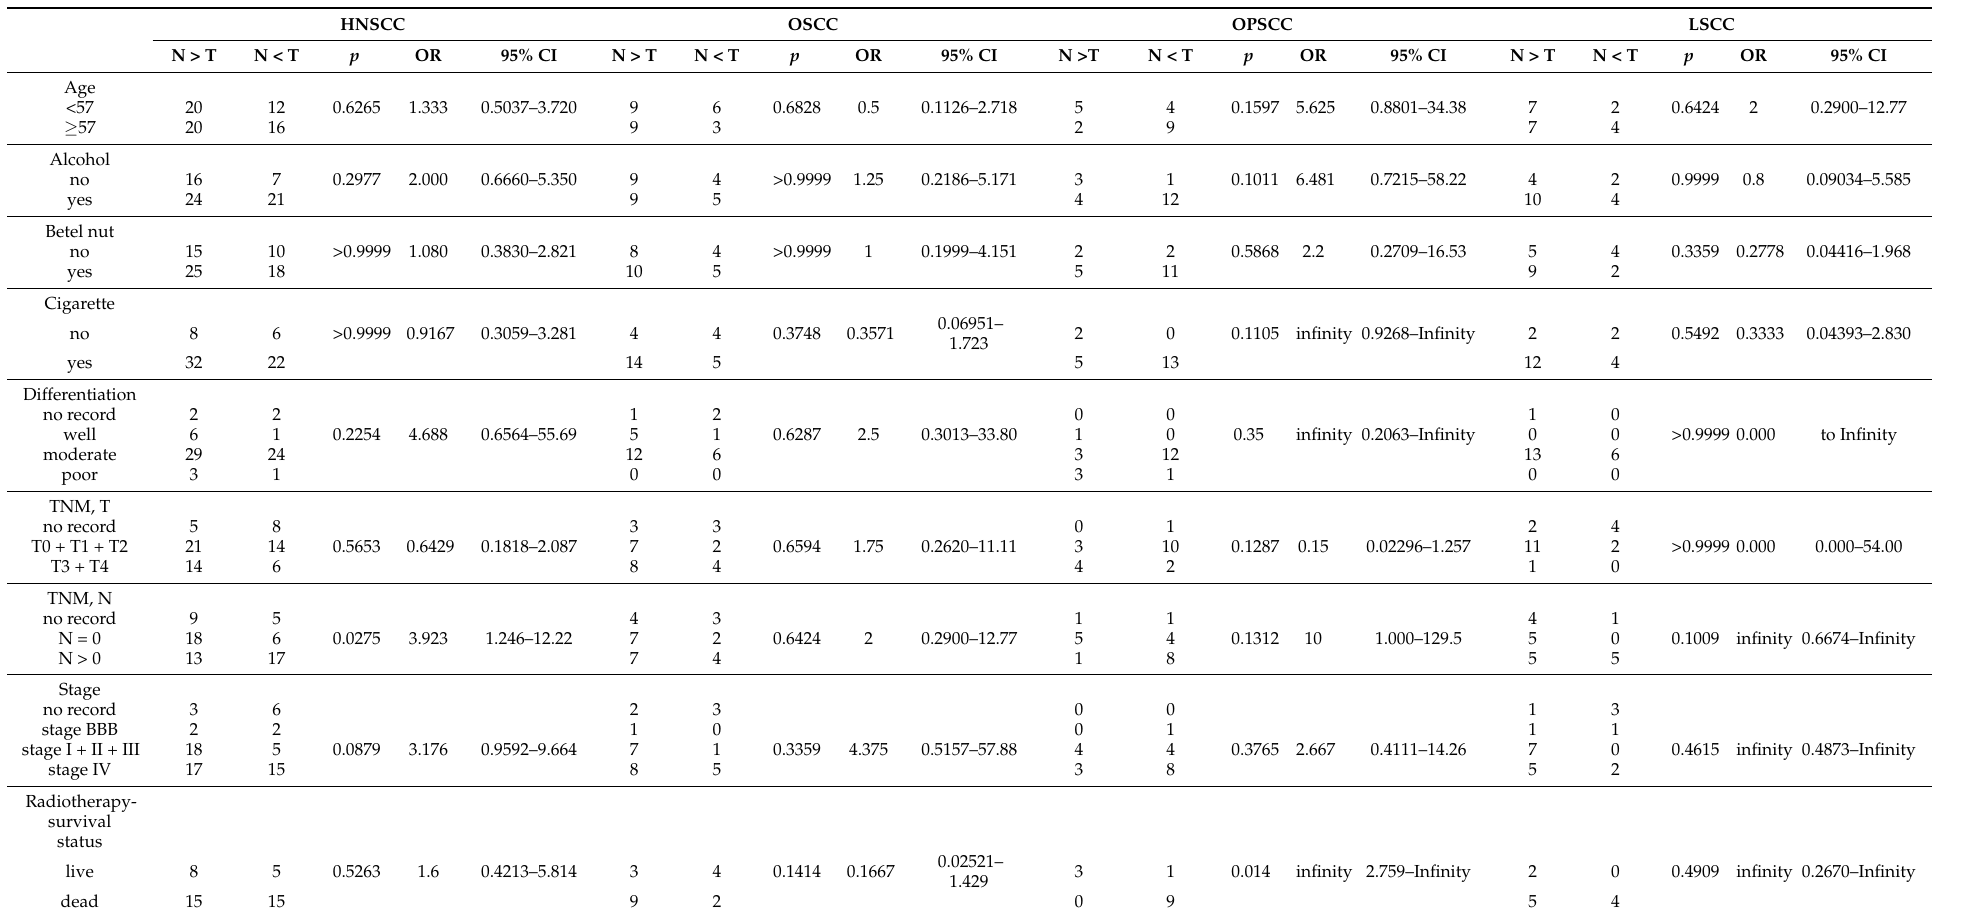
Table 3. Association between GALNT14 expression and clinical parameters in HNSCC and subtype